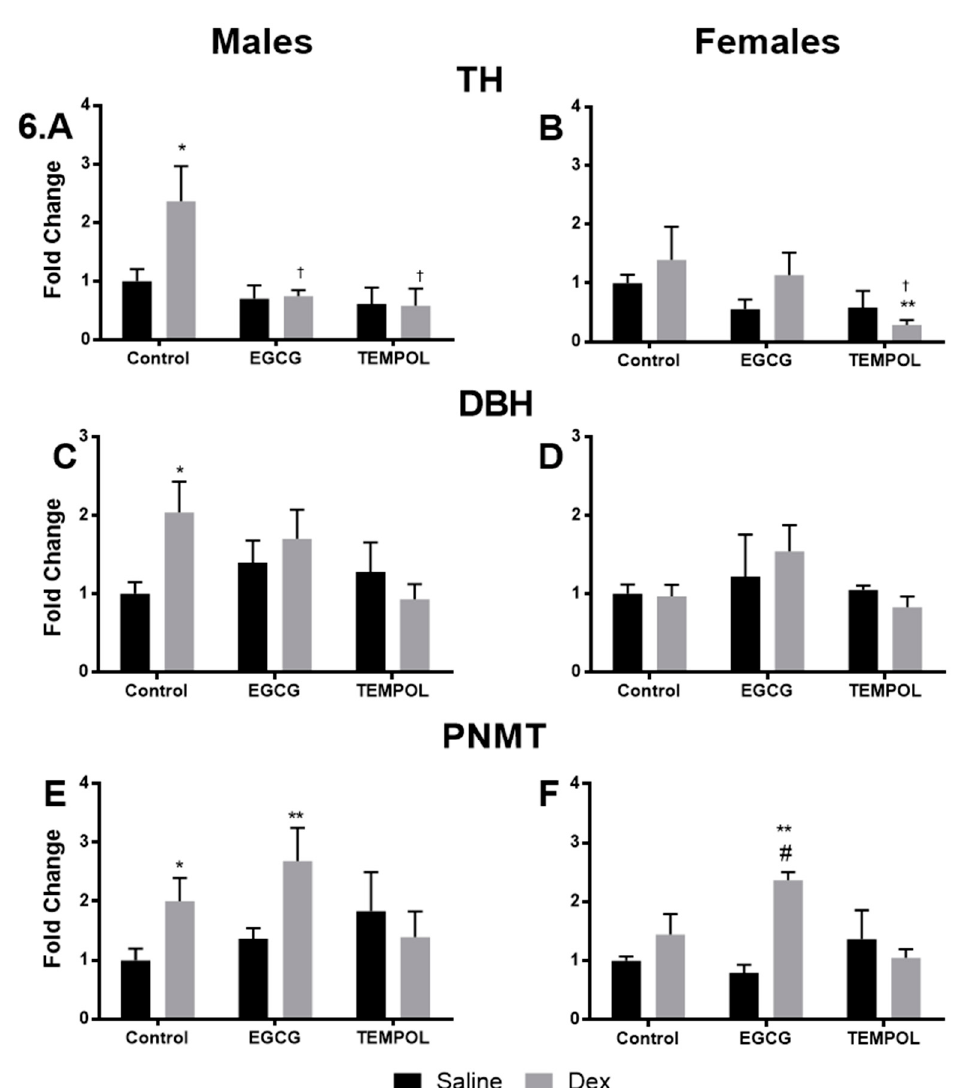
Figure 6. The impact of–in-utero antioxidant administration on adrenal catecholamine biosynthetic enzyme protein levels. Results of western blot for male and female tyrosine hydroxylase (TH) ( A , B ), dopamine beta hydroxylase (DBH) ( C , D ), phenylethanolamine N-methyltransferase (PNMT) ( E , F ) exposed to TEMPOL or EGCG in utero. Saline and Dex control have been published previously and have been provided for reference [7]. Statistical analysis was performed using a two-way ANOVA (Fisher’s LSD test) shown as */†/# p ≤ 0.05, ** p ≤ 0.01. Data are presented as mean ± SEM. Comparison to the Control-Saline group is represented with the symbol (*), (†) for the Control-Dex offspring and (#) relative to EGCG-Saline. N = 4–6 per group. Significant interactions between maternal injection and antioxidant administration were found for PNMT females.